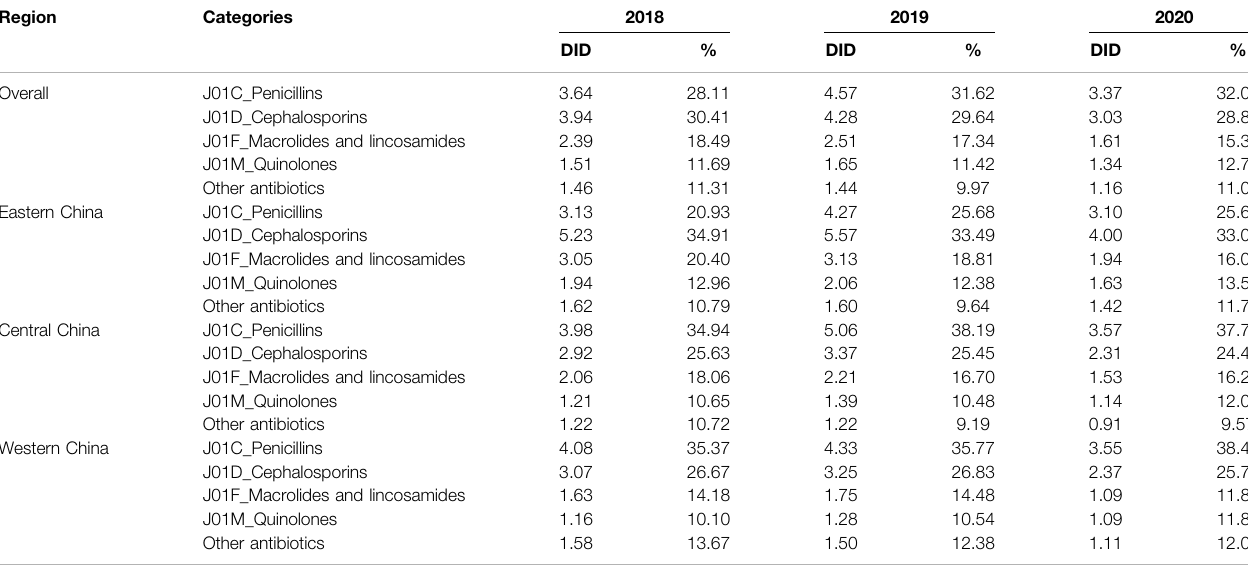
TABLE 3 | Antibiotic consumption by ATC classi fi cation in different regions in China during 2018 – 2020. Region